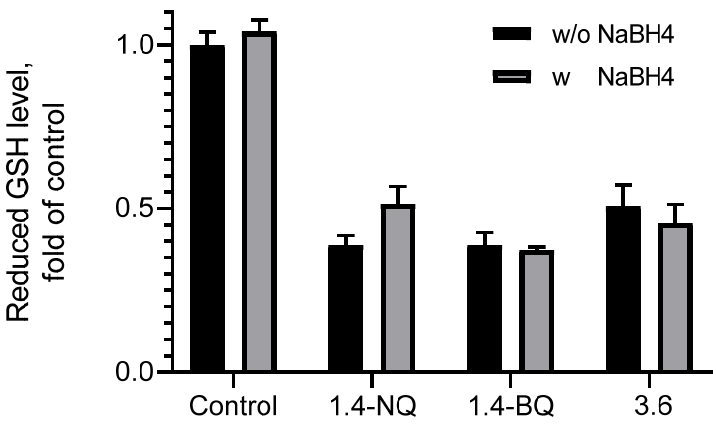
Figure 6. Reduced glutathione (GSH) level.